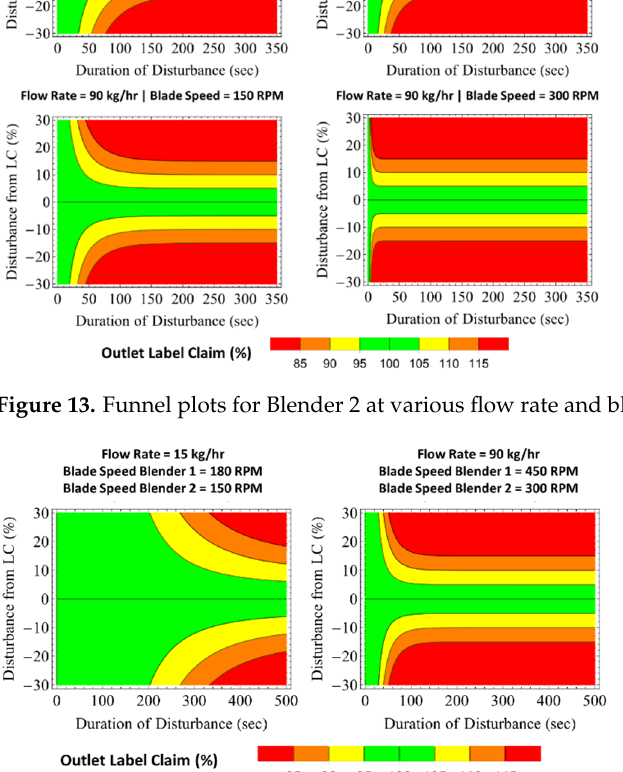
Figure 13. Funnel plots for Blender 2 at various flow rate and blade speed conditions.